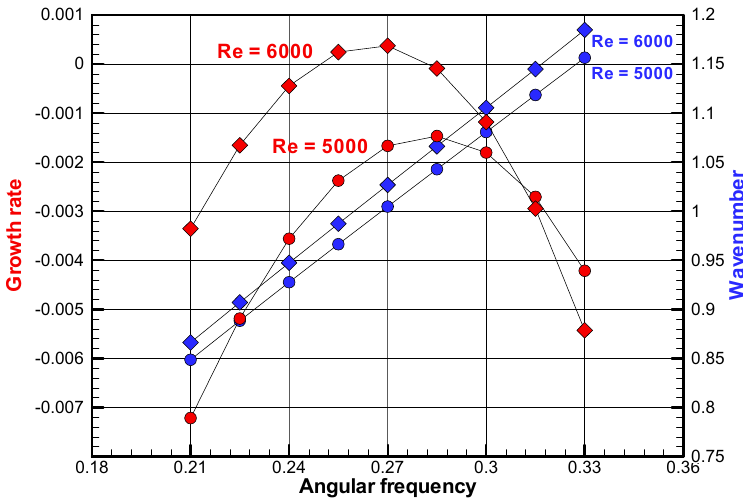
Figure A2. An example of relation among wavenumber, growth rate, and angular frequency for the plane Poiseuille flow for two different values of the Reynolds number ( Re = 5000 and 6000).